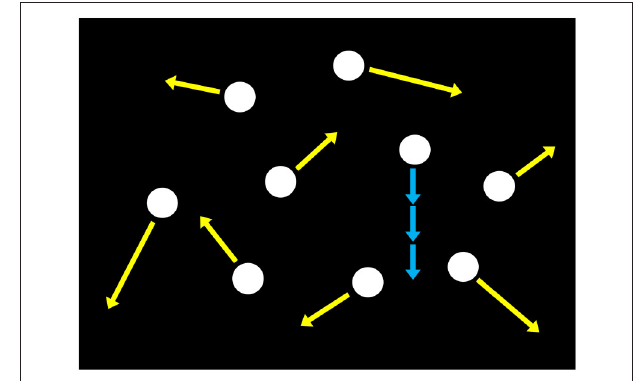
FIGURE 5 | Schematic of the search display used in Experiment 3. Nine luminance dots moved at different velocities and did not to overlap with each other as denoted by yellow arrows. In target-present trials, an average-speeded dot is given a sinusoidal velocity modulation at one of various temporal frequencies (0.25–8Hz) as shown by blue